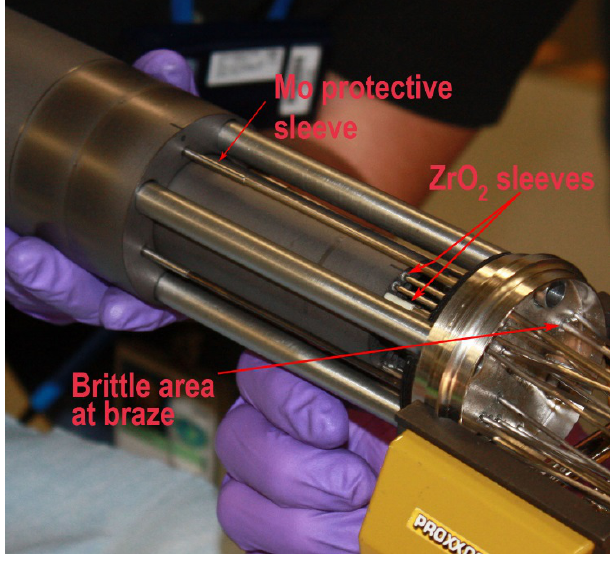
Fig. 3. Capsule 3 protective sleeves and brittle braze area